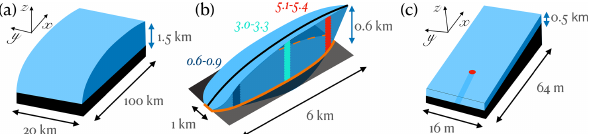
Figure 2. Panels (a) and (b) are sketches of synthetic glacier to- pographies used in SHMIP (de Fleurian et al., 2018): (a) 100km- long ice sheet margin with a maximum thickness of 1500m and (b) 6km-long valley glacier with a 600m altitude difference be- tween summit and terminus. The orange region in panel (b) outlines the intersection of z b = 0 with the ice – note the bed overdeepen- ing. Panel (c) is a sketch of the channelizing test case geometry used for convergence analysis. Note the thickness of the ice and the smaller horizontal spatial scale. The red dot shows the location of the moulin, which has a diameter of